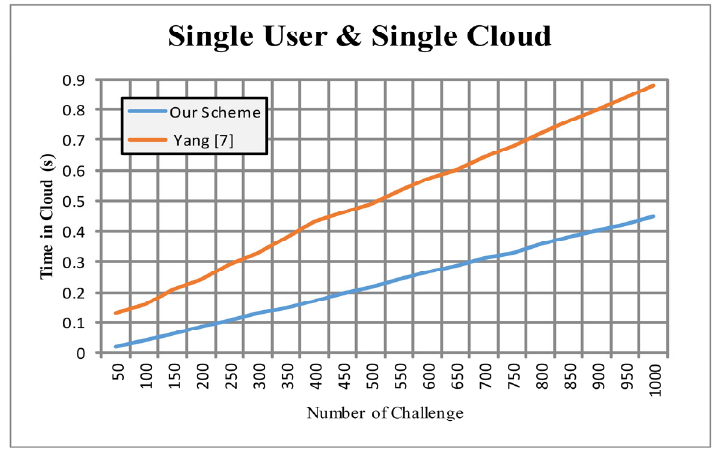
Figure 7. Computation cost for the IoT ‐ cloud system with a single smart device user and single cloud.